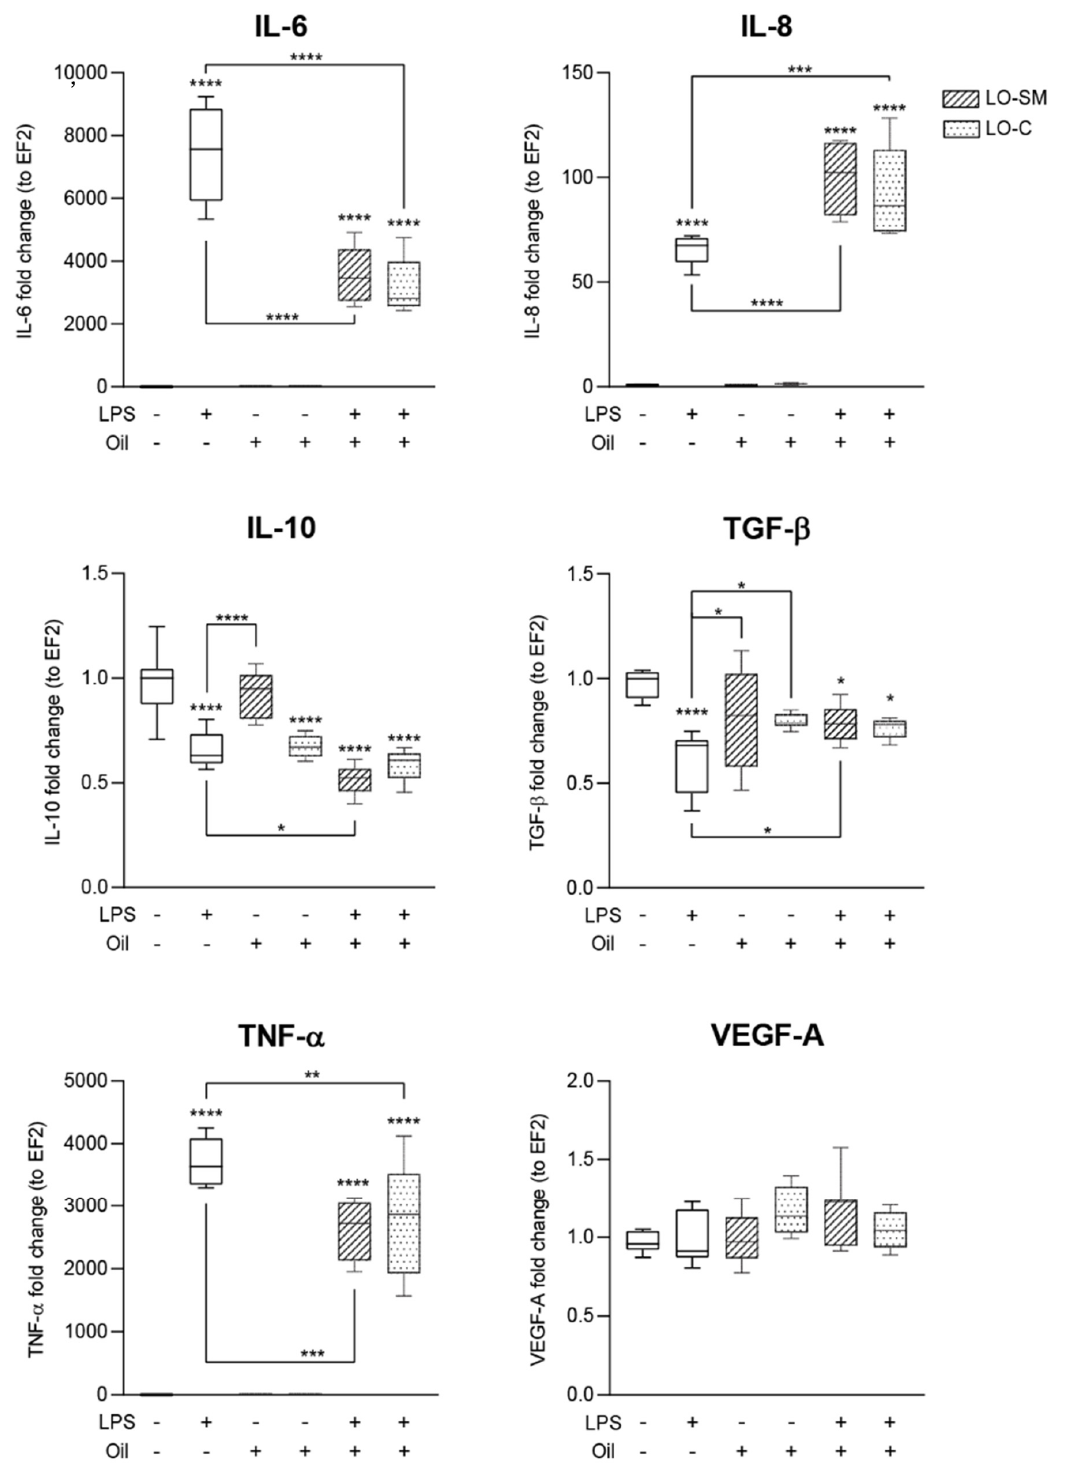
Figure 9. Effect of co-stimulation with lavender oil and bacterial LPS on the expression level of cytokines in human macrophages. hMDM cells were stimulated with 0.05% commercial or in-house preparation of lavender oil and 100 ng/mL of Escherichia coli LPS for 4 h. Level of mRNA production of cytokines: IL-6, IL-8, IL-10, TGF- β , TNF- α , and VEGFA were verified with RT-PCR. Values are mean with range. Groups were compared to the control, and statistical analysis was performed using GraphPad Prism and build-in ANOVA test. Individual comparisons between groups are indicated by the gates. p -values ≤ 0.05 were considered significant. *— p = 0.05–0.011; **— p ≤ 0.01; ***— p ≤ 0.001; ****— p ≤